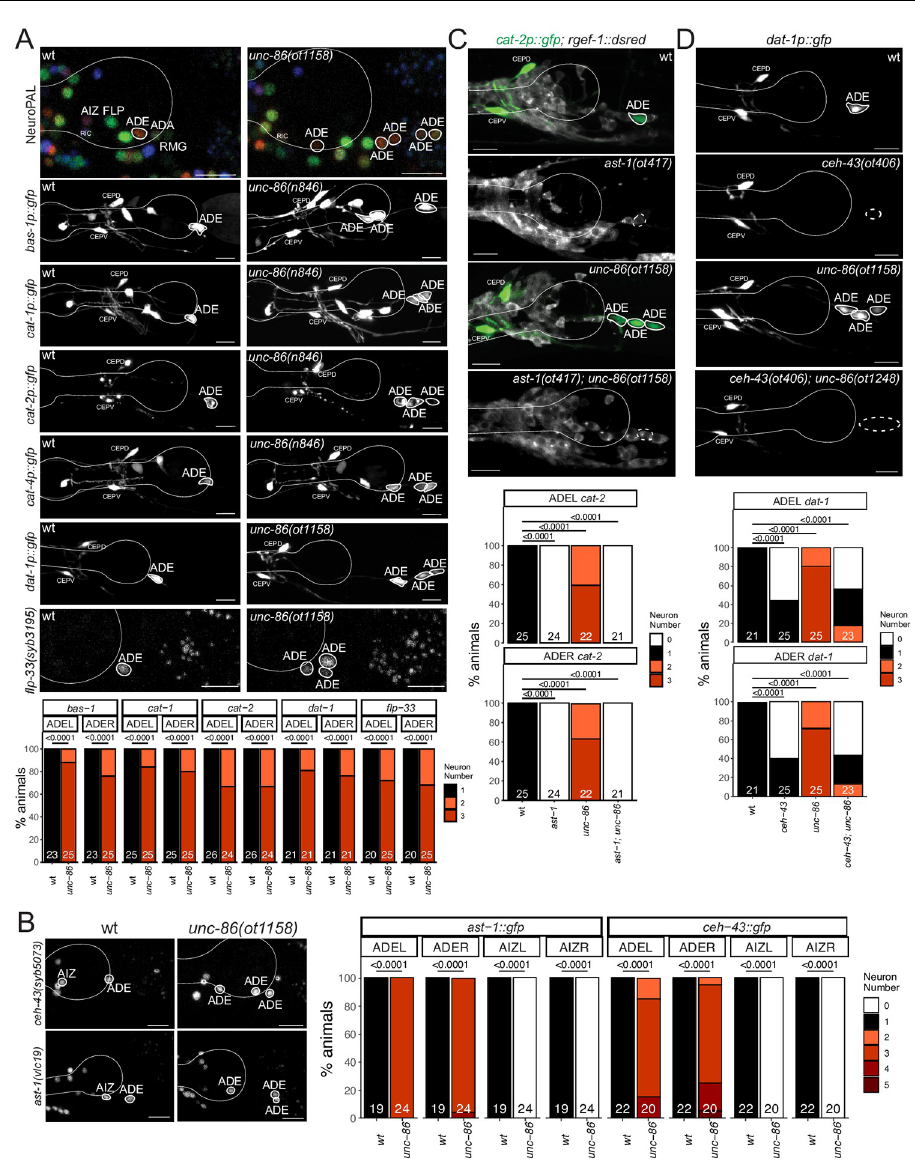
Fig 12. Derepression of dopaminergic terminal feature and dopaminergic regulatory signature in unc-86 mutants. Fig 12A: unc-86 ( ot1158 ) and unc-86(n846) mutant animals ectopically express markers of ADE identity, including NeuroPAL ( otIs669 ), reporter transgenes for genes involved in dopamine synthesis, including bas-1 (otIs226) , cat-1 (otIs224) , cat-2 (nIs118) , cat-4(otIs225) and dat-1(vtIs1) , and a flp-33 CRISPR reporter ( syb3195 ). Representative images of wild type and mutant worms are shown with 10 μ m scale bars. Graphs compare expression on the left side (ADEL) and the right side (ADER) in wild type and mutant worms with the number of animals examined listed at the bottom of the bar. Fig 12B: unc-86(ot1158) mutant animals show a derepression of CRISPR/ Cas9-engineered reporter alleles of ceh-43(syb5073) and ast-1(vlc19) in cells of the anterior deirid lineage. Representative images of wild type and mutant worms are shown with 10 μ m scale bars (non-neuronal expression depicted with an asterisk). Graphs compare expression on the left side (ADEL and AIZL) and the right side (ADER and AIZR) in wild type and mutant worms with the number of animals examined listed at the bottom of the bar. Fig 12C, FigD: ast-1 and ceh-43 are epistatic to unc-86 . The derepression of expression of the cat-2 reporter transgene ( otIs199) in unc-86(ot1158) mutant is suppressed in an ast-1(ot417) or an ast-1(ot406) mutant background. Note that both alleles are hypomorphic alleles (null alleles are lethal) [13,78]. Neurons of interest are outlined in solid white when expressing WT reporter colors, and dashed white when one or all colors are lost. Representative images of wild type and mutant worms are shown with 10 μ m scale bars. Graphs compare expression on the left side (ADEL) and the right side (ADER) in wild type and mutant worms with the number of animals examined listed at the bottom of the bar. In all panels, neurons of interest are outlined in solid white when expressing wildtype reporter colors, and dashed white when one or all colors are lost and P-values were calculated by Fisher’s exact test.